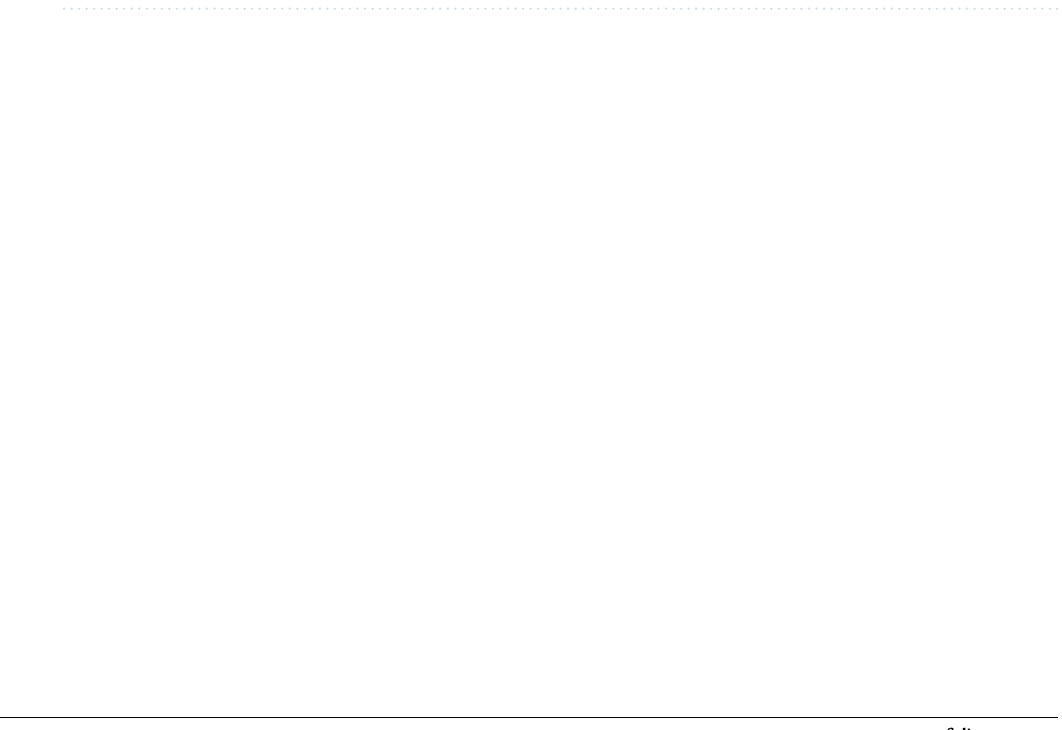
Figure 8. Pooled odds ratio on the association of previous perinatal death and perinatal